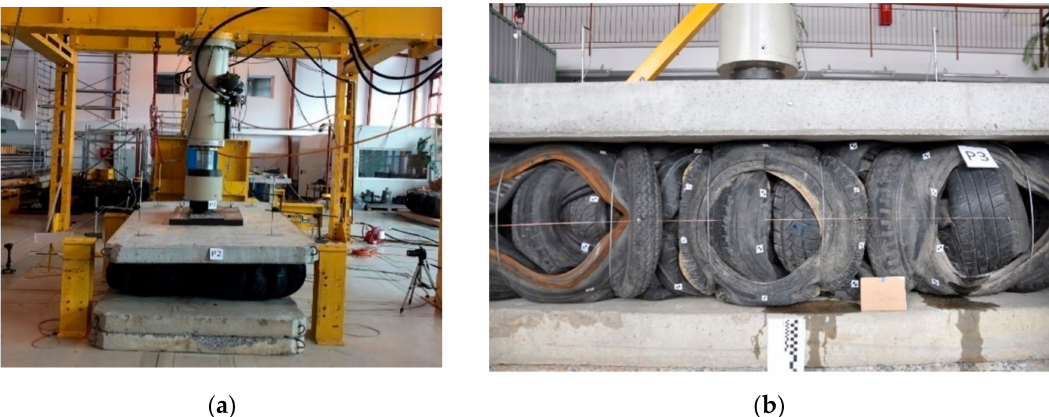
Figure 13. The typical failure mode of tyre bales under compression: ( a ) excessive platen rotation at failure load; ( b ) loose side wires after unloading.